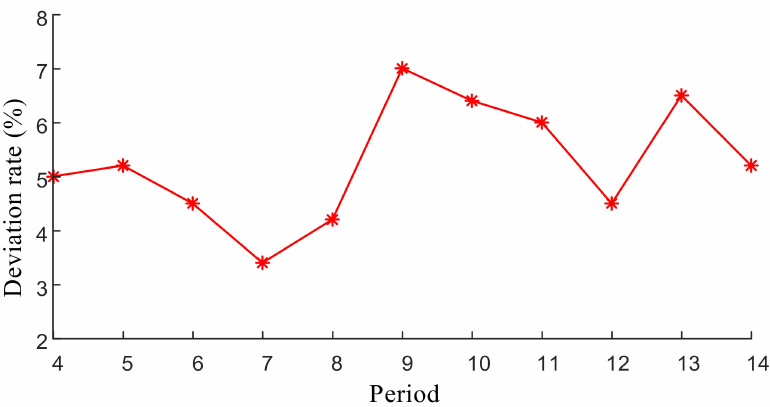
Figure A2. The actual value of controllable capacity deviation rate of the HBES aggregation